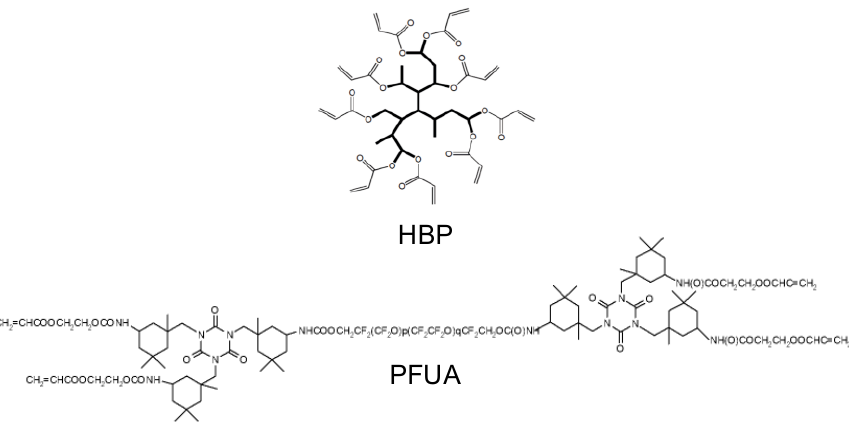
Figure 1. Chemical structure of HBP and PFUA.